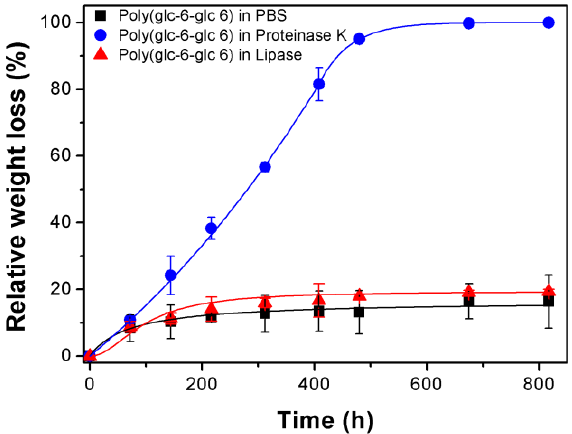
Figure 8. Plot of relative weight loss versus exposure time for poly(glc-6-glc 6) films exposed to PBS, proteinase K and lipase